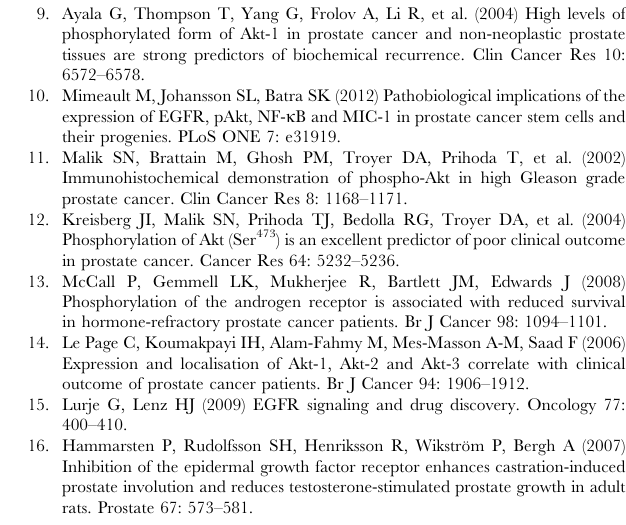
Table S1 Non-parametric partial coefficients for pair- wise comparisons of pAkt-IR vs. clinical parameters with a single controlling factor. Table S2 Non-parametric partial coefficients for pair- wise comparisons of pAkt-IR vs. clinical parameters with a single controlling factor. Table S3 COX proportional-hazards regression analy- ses for tumour pAkt-IR and Ki-67-IR for patients with Gleason scores 8–10 at diagnosis and followed by